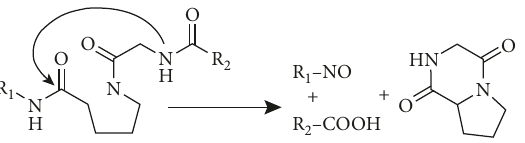
Figure 6: Possible reaction schema for the molecular rearrange- ment of wet-white leather undergoing thermal